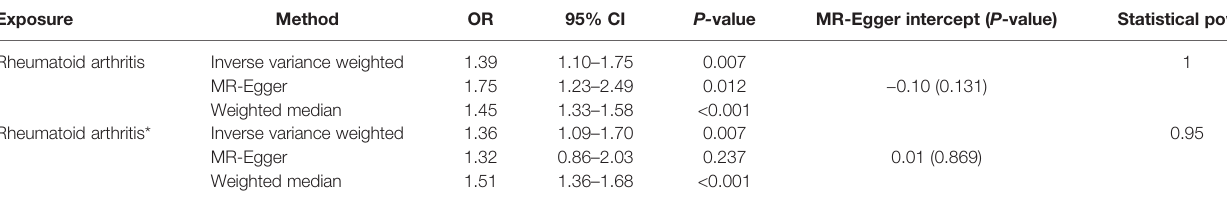
TABLE 2 | Mendelian randomization estimates of rheumatoid arthritis on Graves ’ disease. Exposure